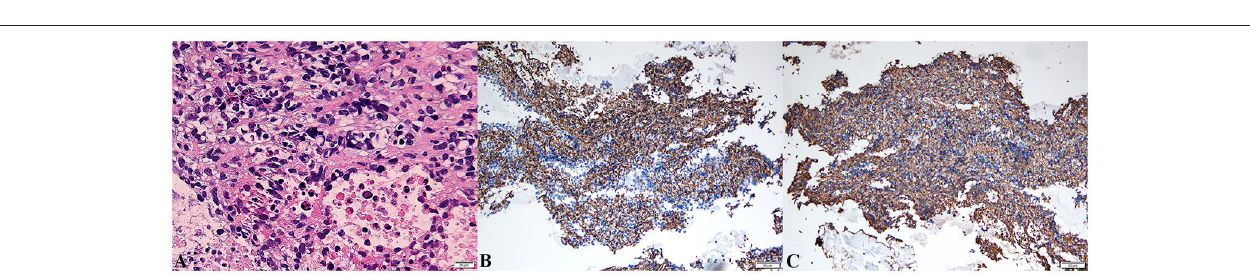
pericardium, poorly demarcated from the RA and superior